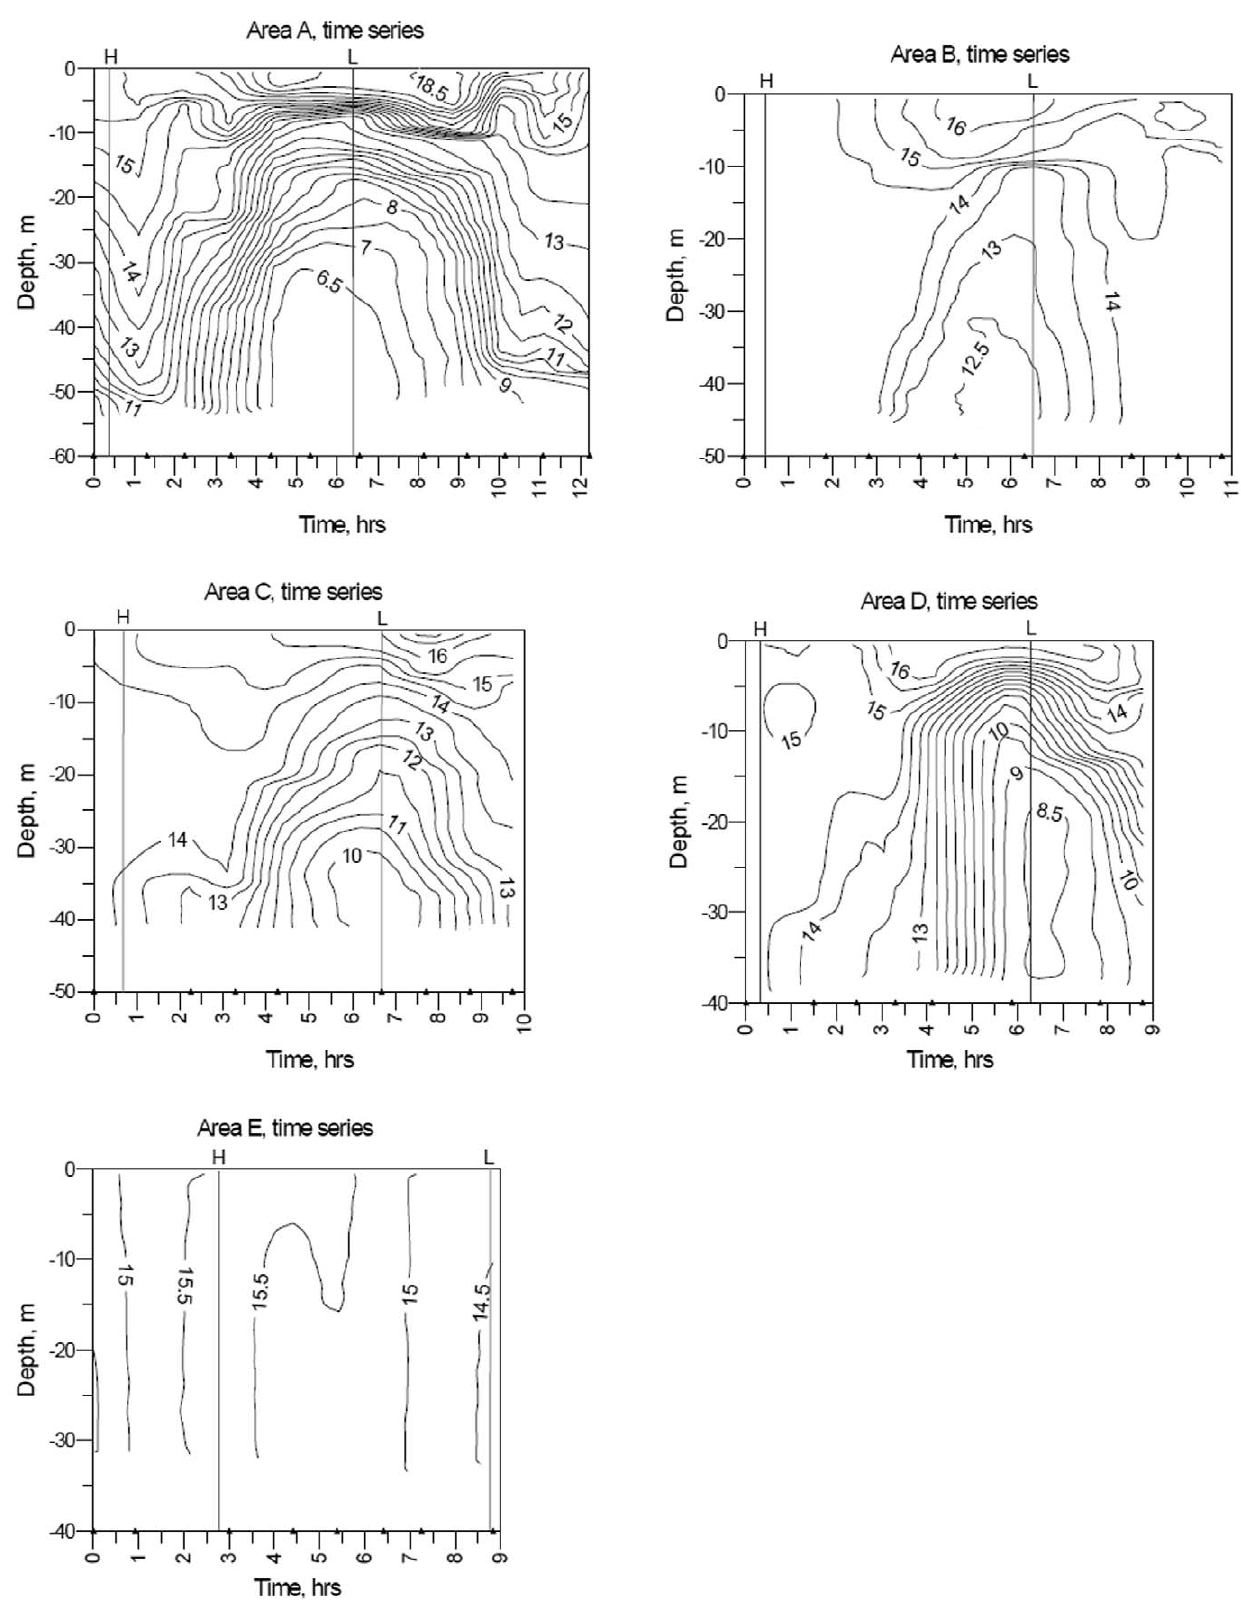
Figure 8. Water-column cross sections at CTD time-series sites in study areas A-E. Data were obtained from the northern margin of Georges BankinAugust2009 (Figs.2,3,4,5,6). Observationswere made over time periods of8.8to12.2 hr (Tables 3, 4).Temperaturecontour interval is 0.5 u C.Vertical lines represent time of high (H) and low (L) tide. Black triangles on the x-axis indicate times of temperature observations after start of time series. doi:10.1371/journal.pone.0055273.g008 PLOS ONE |